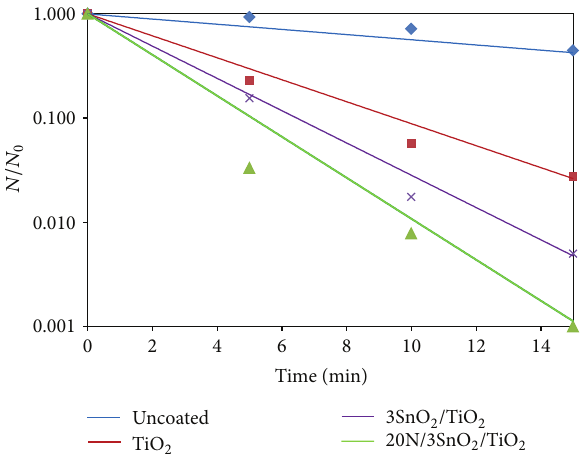
Figure 10: Antibacterial effects of coated glass fibers against S. typhi under UV irradiation.